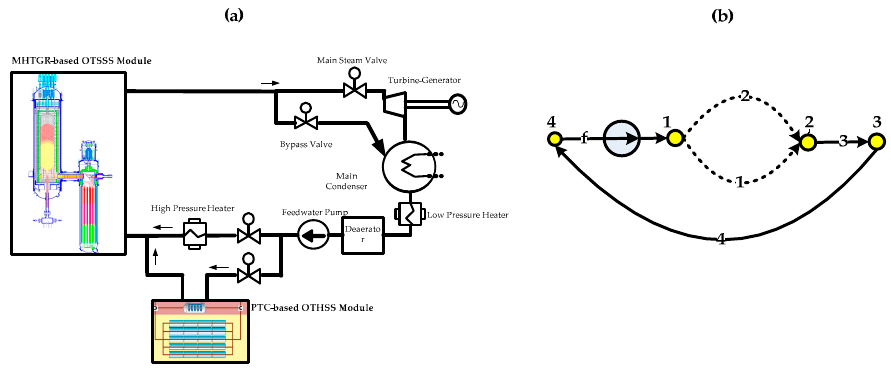
Figure 7. An HES constituted by an MHTGR-based OTSSS module and a parabolic through collector (PTC)-based OTHSS module: ( a ) simplified process diagram; ( b ) structure of the FFN.